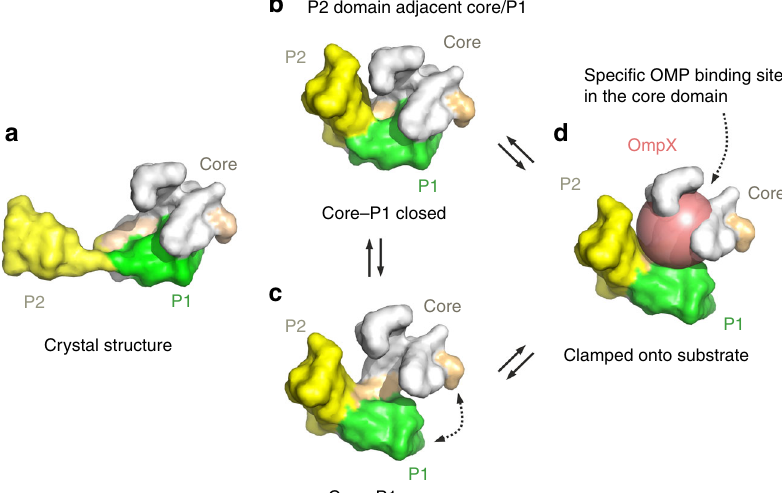
Fig. 8 Summary of SurA conformational dynamics and a proposed mechanism of substrate binding. a The crystal structure of SurA (PDB 1M5Y 27 ). Note that this conformation is not signi fi cantly populated in solution, as demonstrated here. Instead, in solution the P2 domain is mostly found close to the core/ P1 domains ( b , c ). In these conformations the P1 domain can adopt b core-P1 closed and c core-P1 open states. d Substrate binding results in the P1 domain adopting a structure intermediate between core-P1 open and core-P1 closed . Our data are consistent with the OMP client being captured as a dynamically unfolded state 43 within a cradle formed by the three domains of SurA. Whether SurA-bound OMP is in a collapsed globule (represented here as a sphere) or a more extended state remains unclear. However, the XL data are consistent with the presence of multiple, speci fi c OMP recognition sites on SurA, suggesting a dynamic ensemble of bound structures. Note that the images presented are schematic and aim to portray the dynamics of the P1, P2 and core domains relative to each other, rather than atomic-level